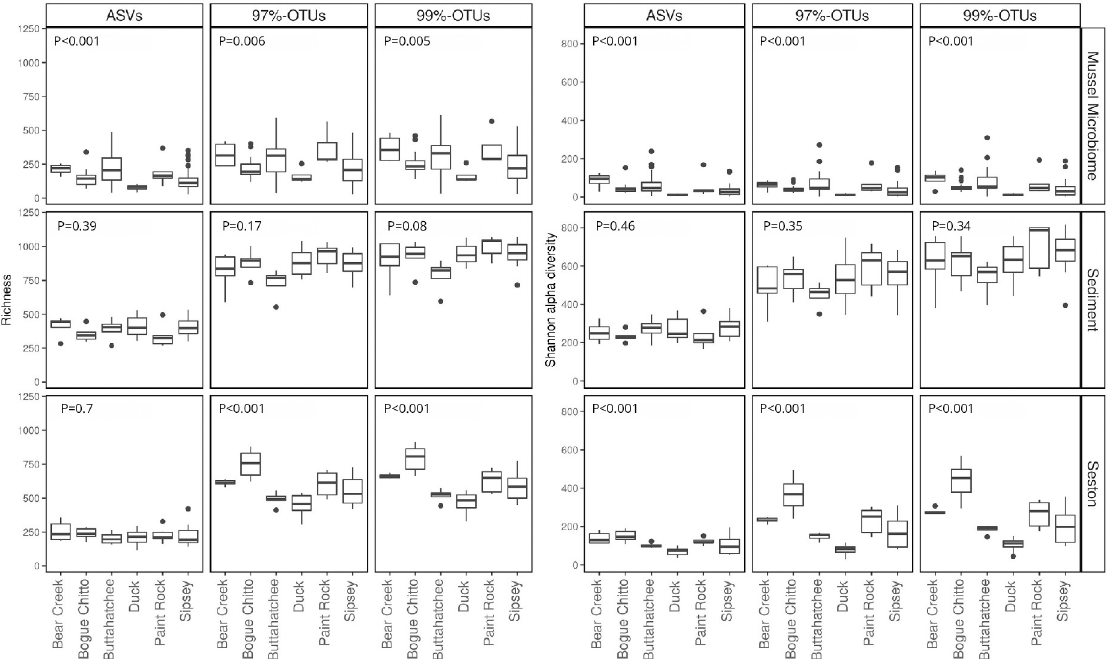
Fig 3. Effect of sequence processing methodology on ecological patterns of microbial alpha diversity. Distribution of alpha diversity values on each river is represented by a boxplot. Kruskal-Wallis tests assessed significant differences between rivers with p-values indicated on each panel. Types of communities are represented using horizontal panels. Patterns within ASVs, 97%-OTUs, and 99%-OTUs are compared using the three vertical panels on each plot. The richness index (left plot) and Shannon alpha diversity (right plot) are represented for each community type and sequence processing